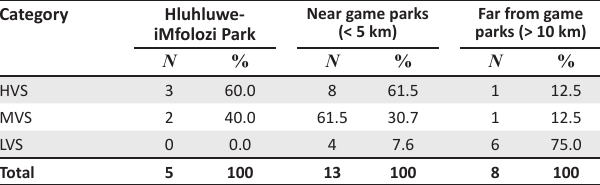
TABLE 3: Prevalence and distribution of high, moderate and low virulence strains in the study areas. Near game parks Far from game Category Hluhluwe- (< 5 km) parks (> 10 iMfolozi Park